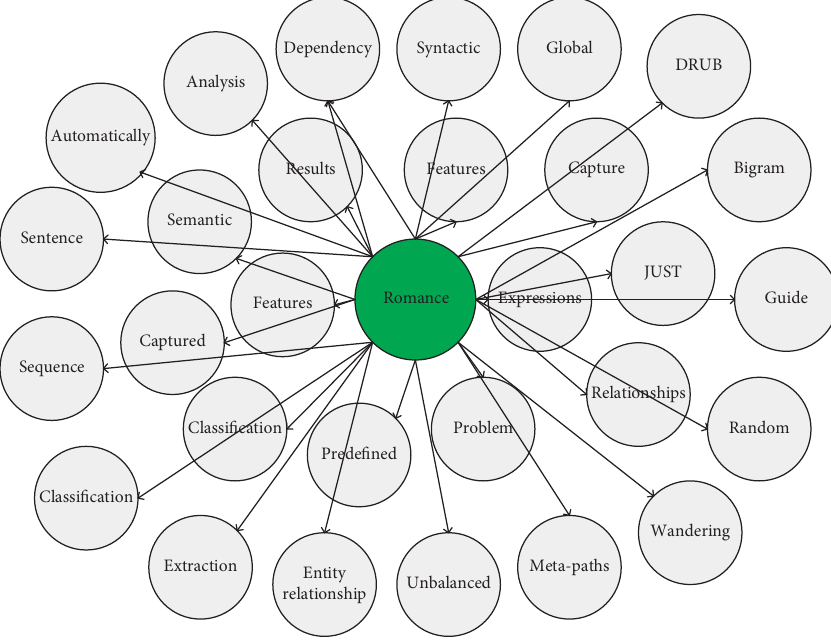
Figure 8: Entity example diagram.